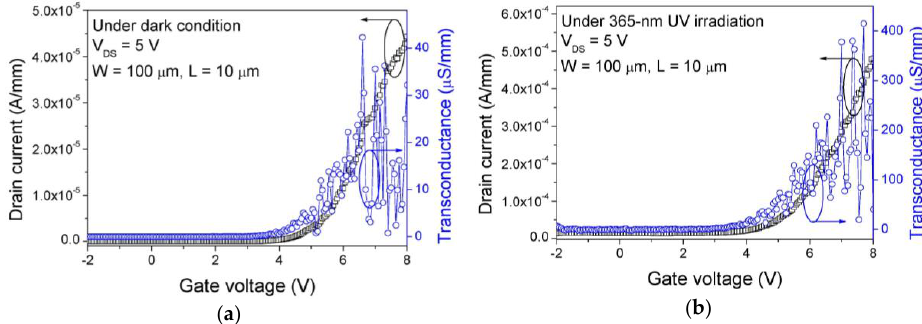
Figure 5. Transfer I DS – V GS characteristics of the fabricated GaN SB-MOSFET ( a ) under dark and ( b ) under 365-nm UV irradiation.